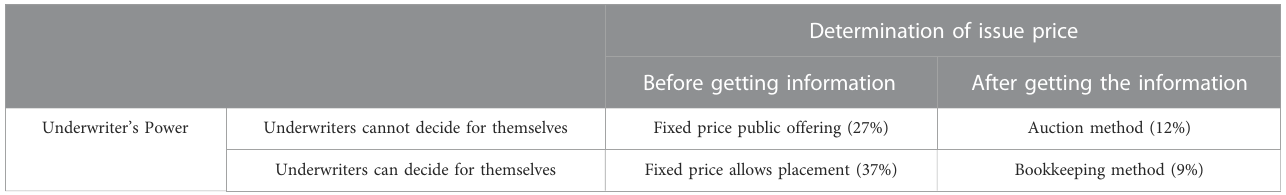
TABLE 3 Comparison of general initial income of IPO pricing